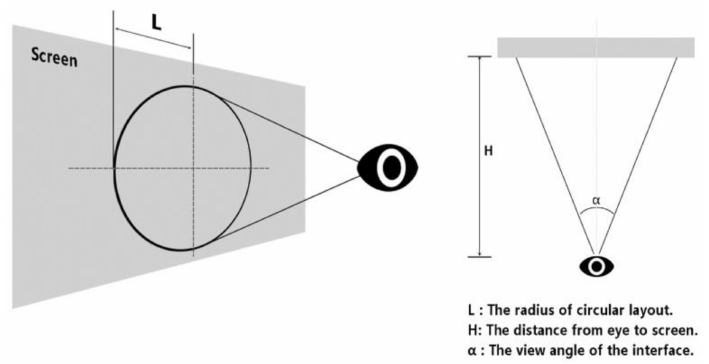
Figure 7. Schematic diagram of experimental target distance.